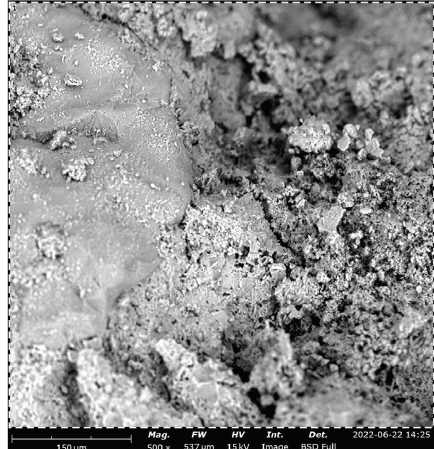
Figure 25: SEM for M1